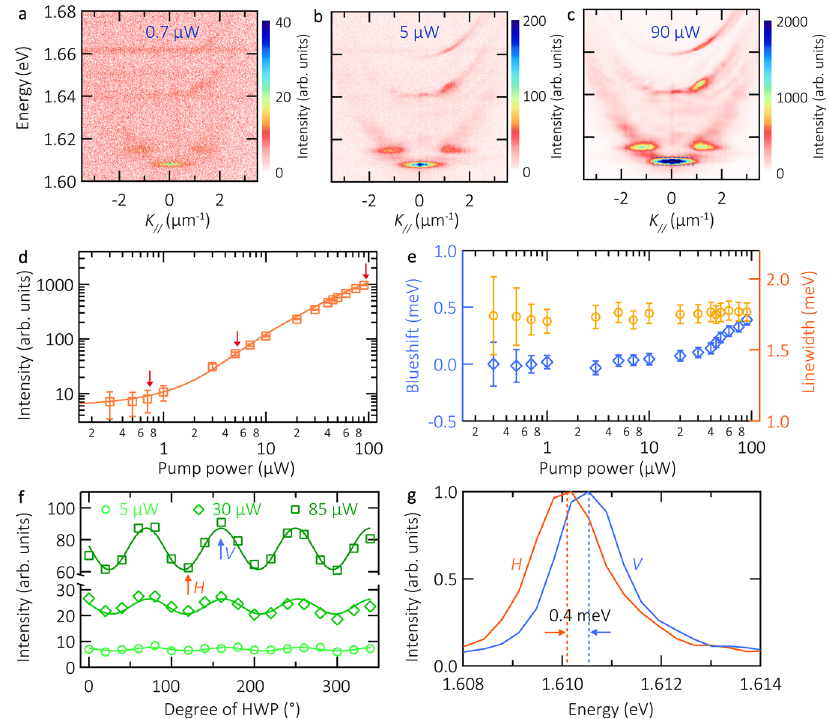
Fig. 3 Density-dependent properties of room temperature exciton-polaritons. a – c Polariton dispersion relations under 0.7, 5, and 90 μ W pump power excitation. Intensity counts are encoded in a false color scale. The acquisition time for each dispersion relation is 180 s. d Integrated PL emission intensity as a function of pump power, plotted in a double-logarithmic scale. The solid line is a simulation obtained by solving the Boltzmann equation. The arrows indicate the corresponding dispersion relations shown in panels a-c. The error bars are obtained by comparing the polariton signal intensity to the standard deviation of the background noise. e Corresponding blueshift (blue diamonds) and linewidth (orange circles) of exciton-polaritons as a function of pump power. The blueshift and linewidth error bars correspond to the 95% con fi dence interval of the peak fi tting. f Linear polarization emission intensity analyzed as a function of the half-waveplate angle at three different pump powers. Each data point corresponds to the averaged intensity within the trapped state. The labels H and V indicate the two orthogonally-polarized states of the trap. g Corresponding H and V spectra, displaying the trap fi ne structure splitting of 0.40 ± 0.03 Simultaneously, in Fig. 3e we investigate the blueshift (blue, left axis) and linewidth (orange, right axis) of the trapped state versus pump power. The blueshift increases slowly up to a pump power of 40 µW, while a stronger increase up to 0.4 meV is observed in the high-density regime.